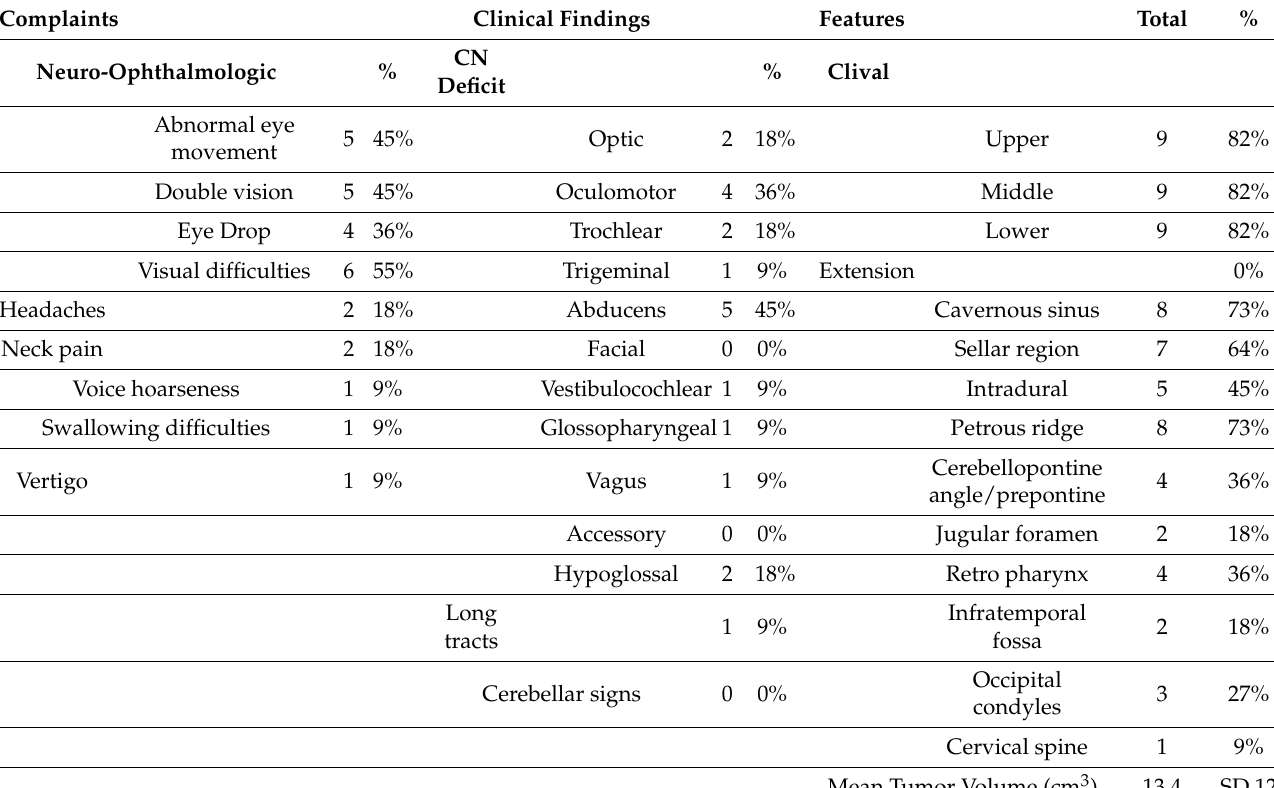
Table 2. Chief complaints, clinical findings, and tumor